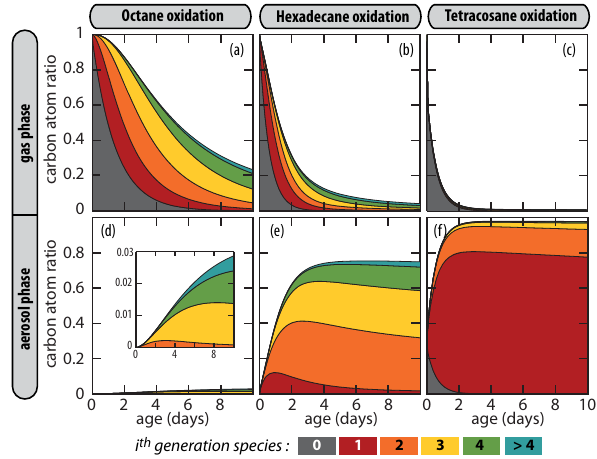
Fig. 3. Partitioning of organic carbon during hexadecane oxidation Figure 3: Partitioning of organic carbon during hexadecane oxidation in the gas and aerosol phases as in the gas and aerosol phases as a function of C OA . Colors identify a function of C OA . Colors identify the contribution of the species from a given generation to the total the contribution of the species from a given generation to the total carbon budget. carbon budget.